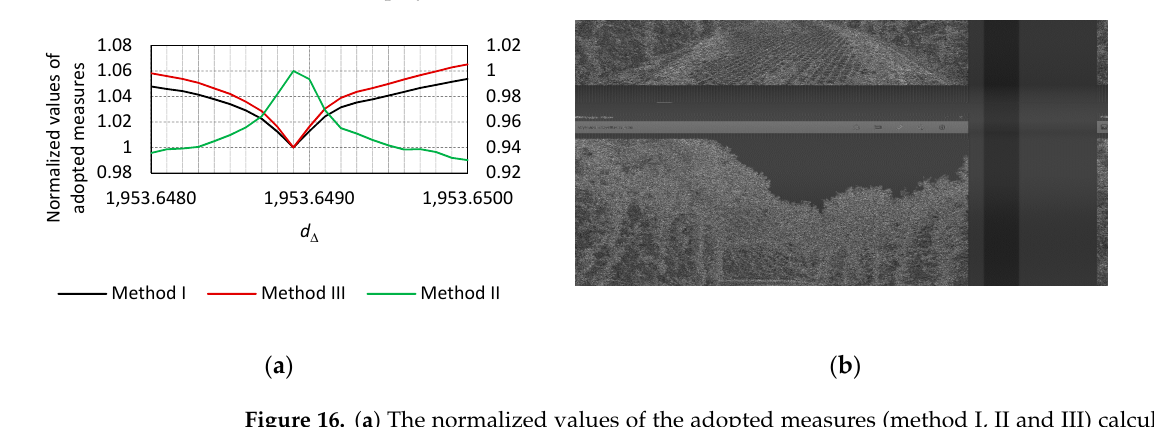
Figure 16. ( a ) The normalized values of the adopted measures (method I, II and III) calculated in domain of image line length d ∆ for the accuracy ∆ = 0.0001 (for the original image shown in Figure 7a) and ( b ) image reconstructed on the basis of the recorded revealing emission signal at frequency f o = 1334 MHz (receiving bandwidth BW = 50 MHz) for estimated line length d ∆ = 1953.64890 (accuracy ∆ = 0.0001)—multiple of image summation Sum MTL = 30, the source of revealing signal emission—display monitor, HDMI standard.